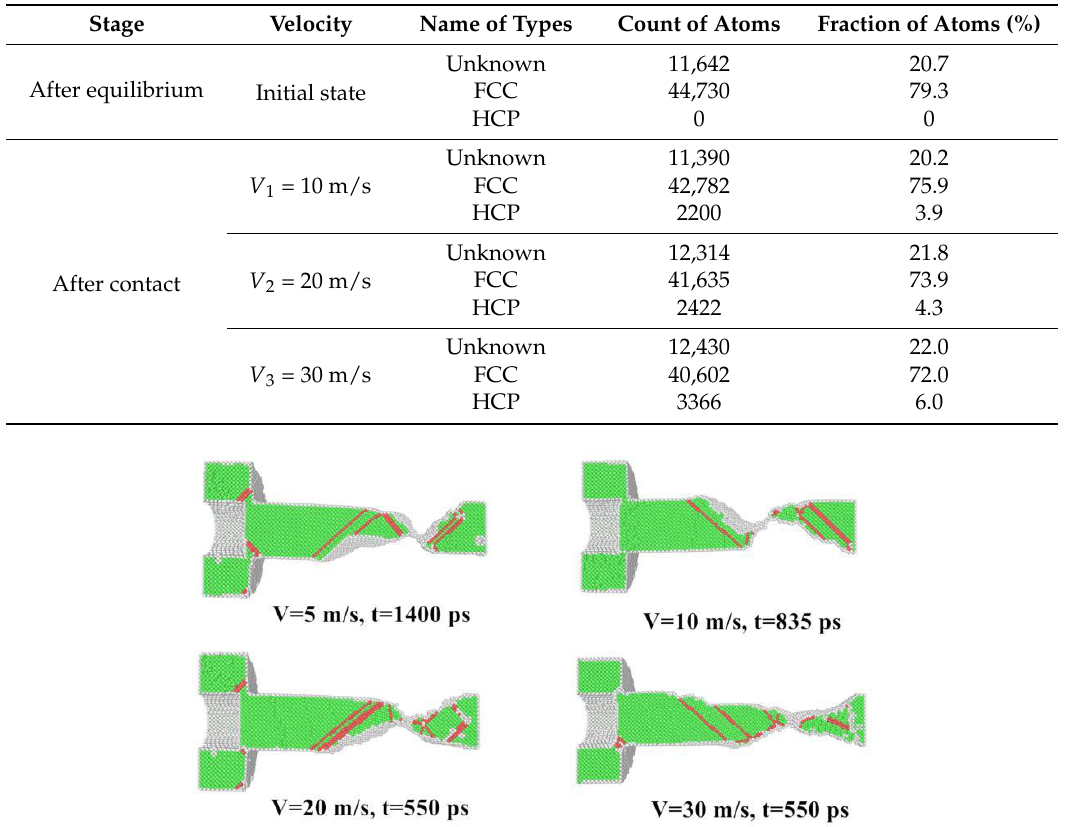
Table 2. Summary of the structure types of bearing-sleeve at various rates.